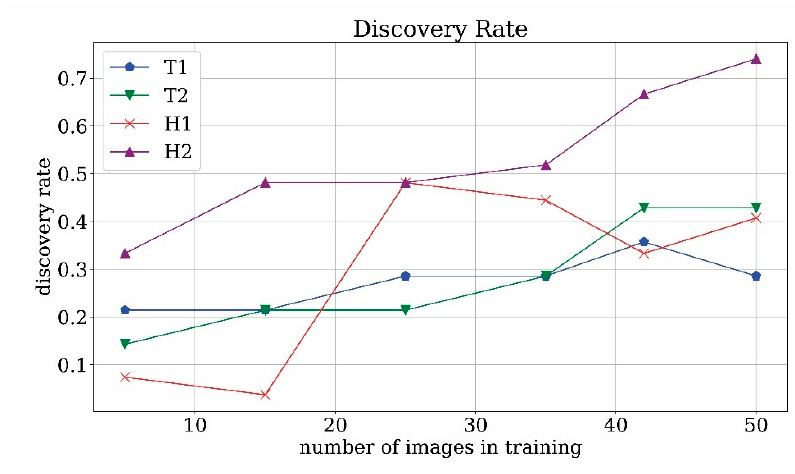
Figure 21. Discovery Rate analysis.